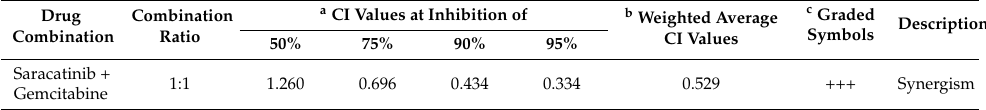
Figure 6. Cytotoxicity of gemcitabine and saracatinib, alone or in combination, in Huh-7 cells. Cells were treated with increasing concentrations of gemcitabine or saracatinib alone, or in combination for 48 h and cell viability was measured using the CellTiter 96 ® AQ ueous One Solution Cell Proliferation Assay. Data represent means ( ± SD) of at least two independent experiments performed in duplicate. Table 2. Synergistic antiviral effect of saracatinib and gemcitabine.